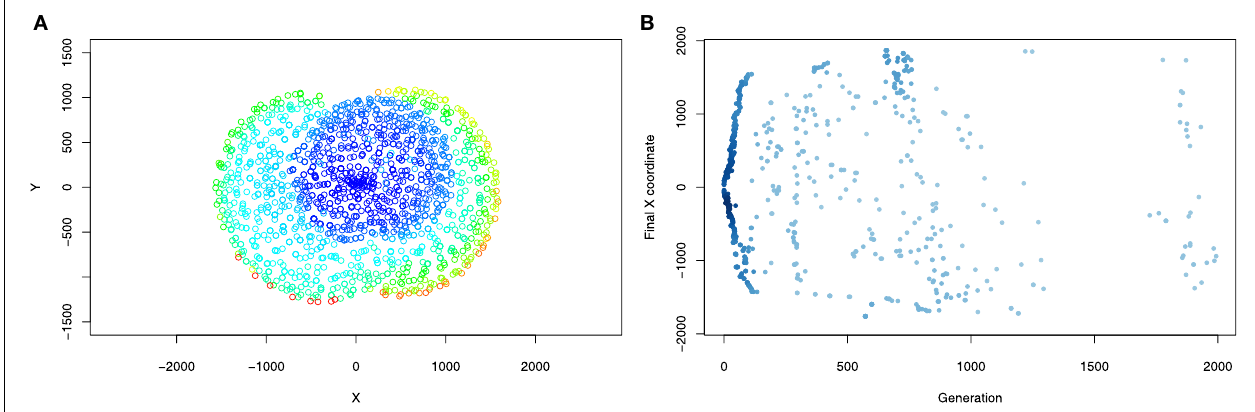
FIGURE 10 | The contents of novelty archives in runs shown in Figures 8 and 9 (bottom rows) after 2000 generations . Points represent individuals in the same manner as in the Figures 8 and 9 . (A) Aquatic environment, (B) terrestrial